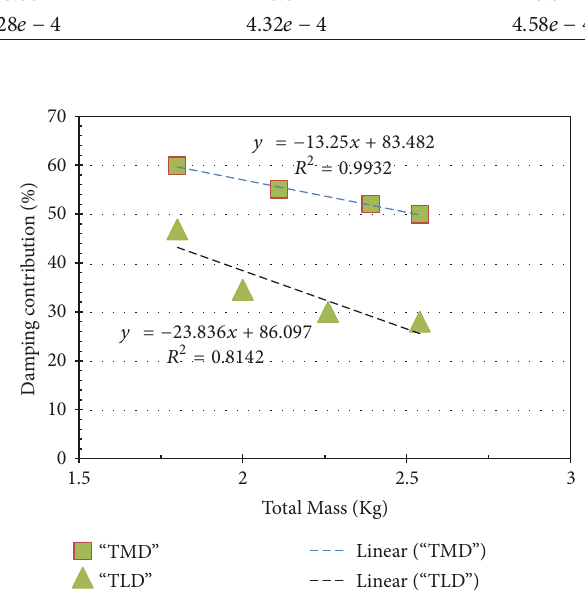
Figure 7: Damping contribution with effective mass of the TMD and TLD controlling